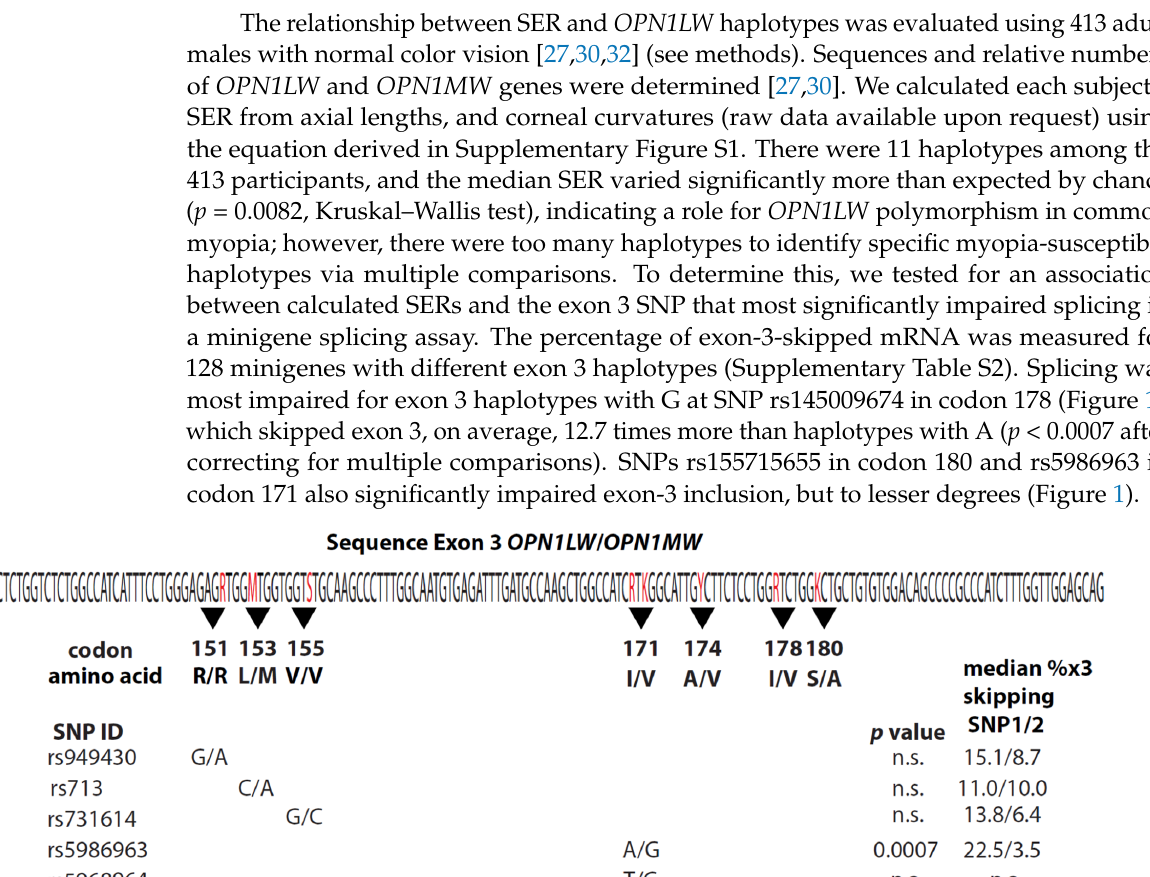
U). The mean calculated SER for the two groups differed by 1.36 D ( − 1.1486 vs. −